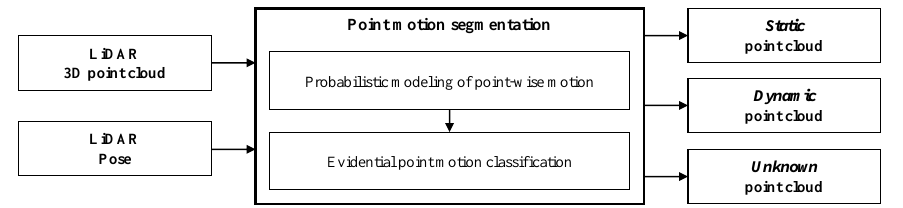
Figure 1. System architecture of the rapid point motion segmentation